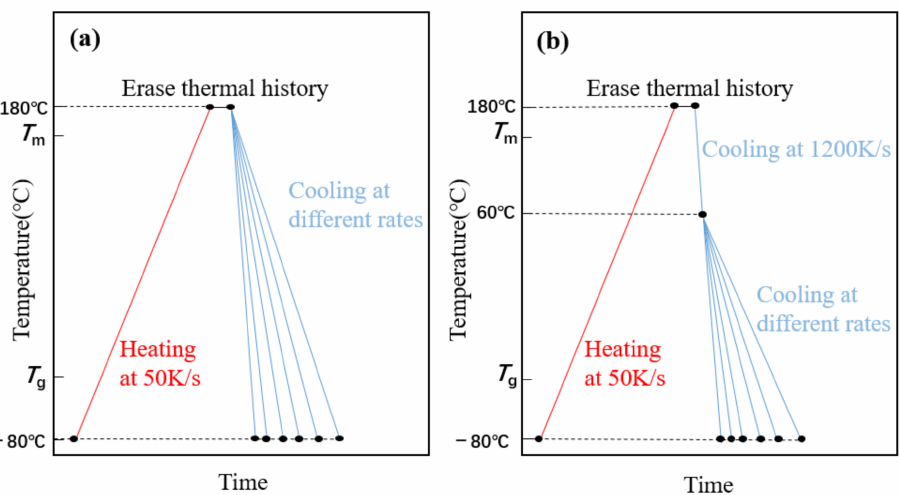
Figure 1. ( a ) Time—temperature profile of method 1. ( b ) Time—temperature profile of method 2 (the highest temperature is 180 ◦ C for 1 s to erase the thermal history, the middle temperature is 60 ◦ C and the lowest temperature is − 80 ◦